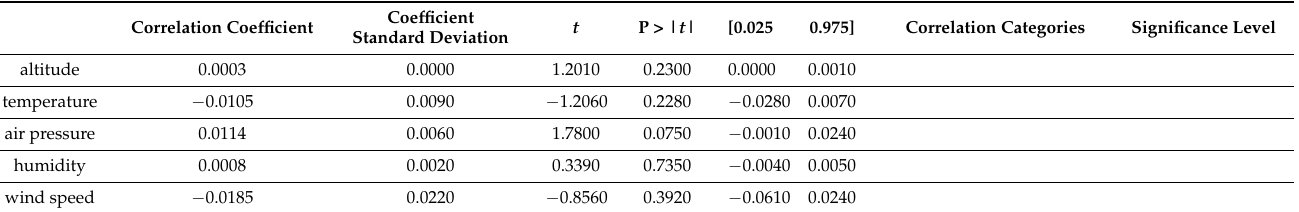
Table 6. The correlation performance of each feature when the dependent variable is average paddle frequency difference of